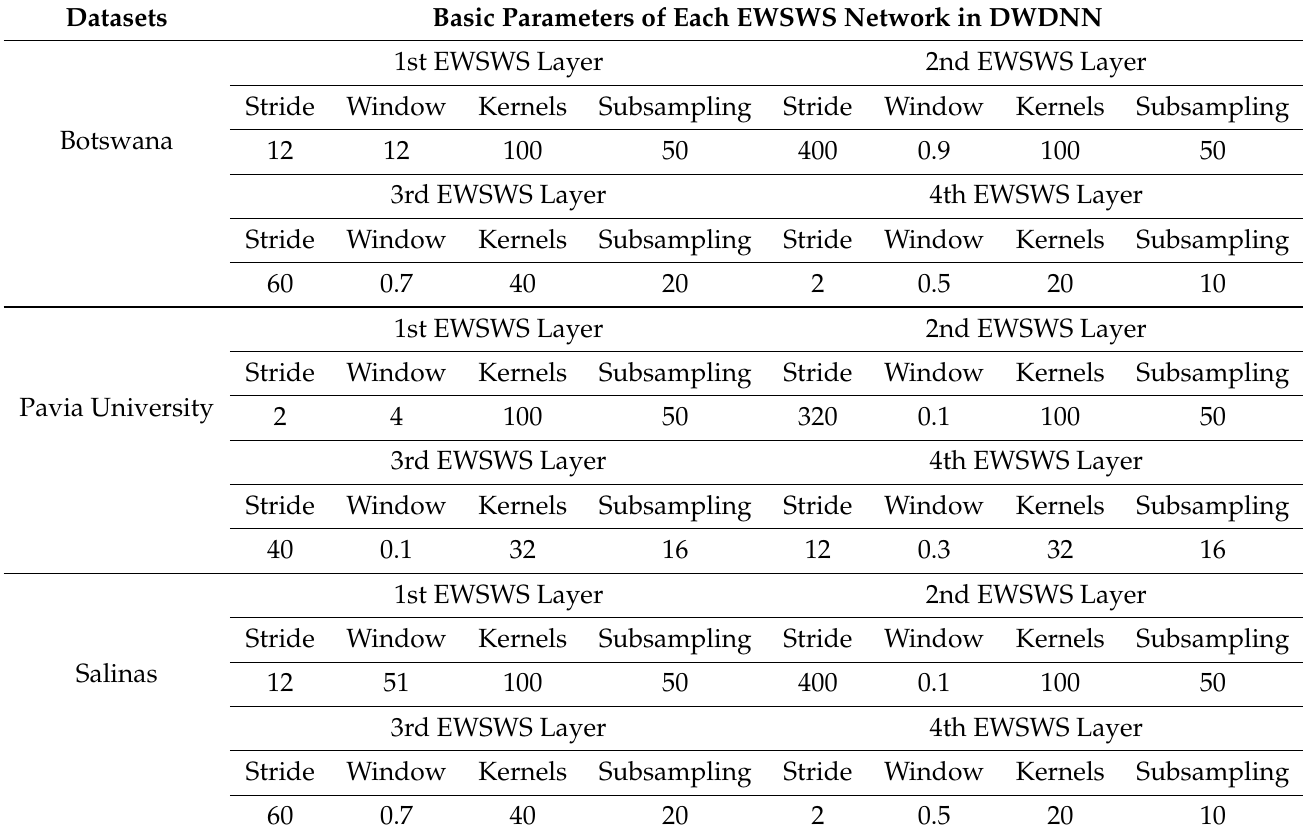
Table 2. Parameter settings for the DWDNN on different hyperspectral datasets. Datasets Basic Parameters of Each EWSWS Network in